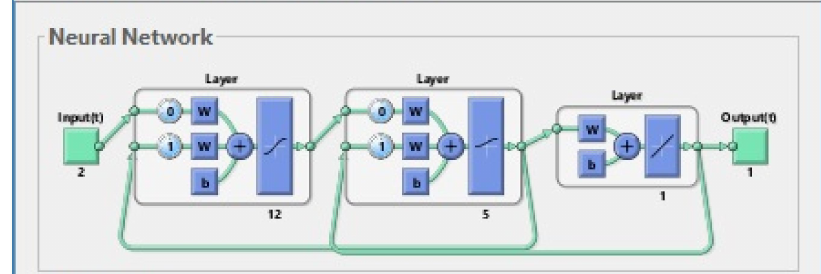
Fig. 3 Design of Jordan Recurrent Neural Network